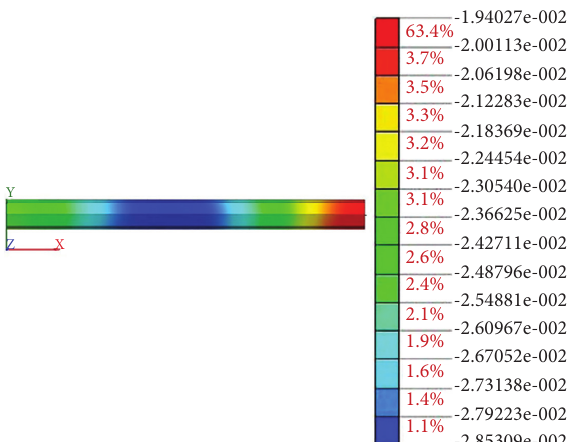
Figure 13: Pipeline deformation cloud